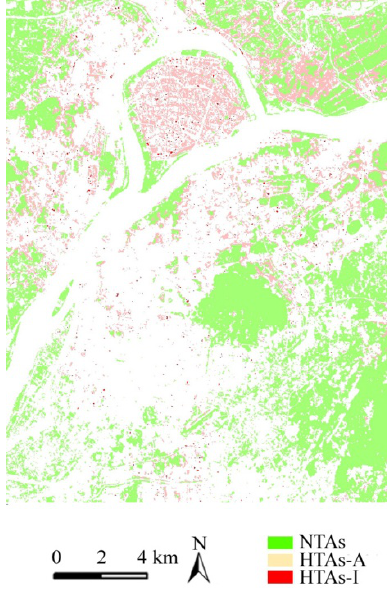
Figure 6. The spatial types of HTAs and